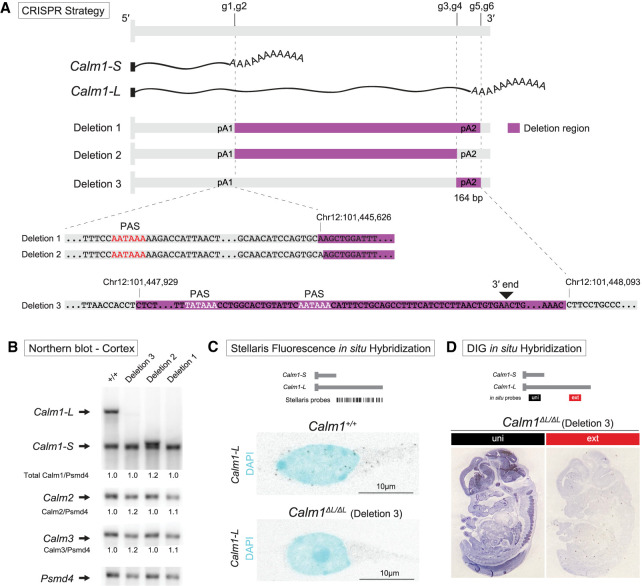
Generation of Calm1 long 3′-UTR deletion mice using CRISPR–Cas9. (A) Diagram of the strategies used to eliminate the production of mature long Calm1 3′-UTR transcripts. Six gRNAs (g1–g6) were injected simultaneously to generate a variety of deletions (Deletion 1–3). (B) Calm1 northern blot of adult cortex from three deletion strains and control littermate demonstrating successful deletion of the long Calm1 3′-UTR isoform. Note the Deletion 2 line generates a new isoform with a truncated long 3′-UTR due to the preservation of the distal PAS. Transcripts from the Calm2 and Calm3 genes were found to be unaltered. Psmd4 used as a loading control. (C) Complete loss of Calm1-L in the Calm1ΔL/ΔL (Deletion 3) hippocampal neurons has been confirmed by lacked smFISH signals representing Calm1-L. (D) DIG in situ performed in the Calm1ΔL/ΔL (Deletion 3) embryo also revealed no expression of Calm1-L.